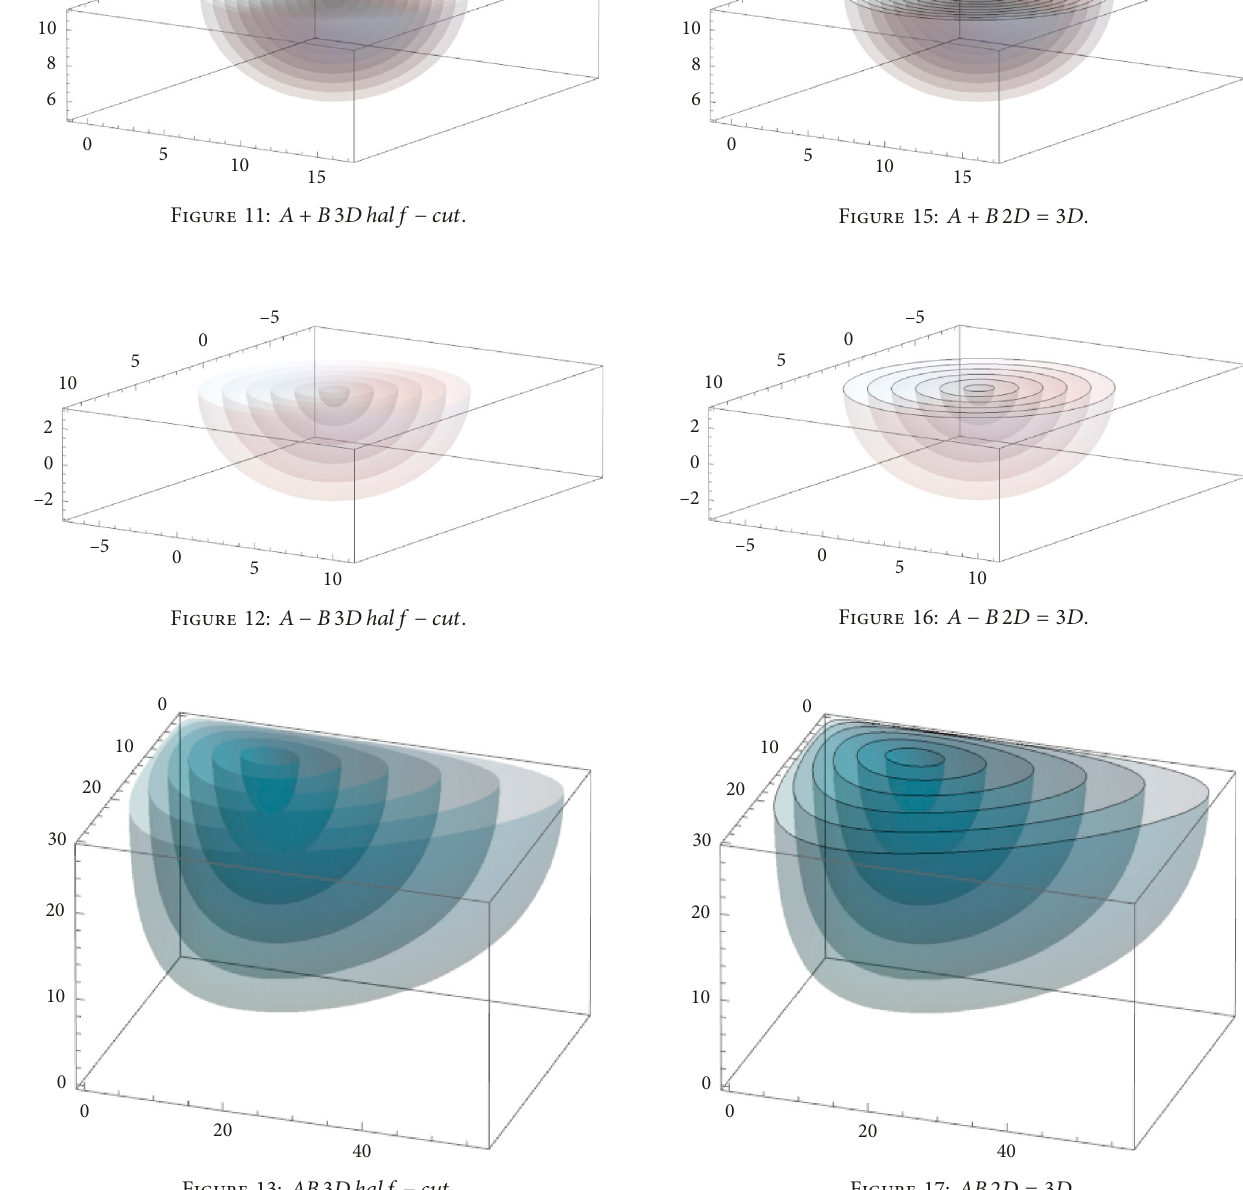
Figure 17: AB 2 D � 3 D